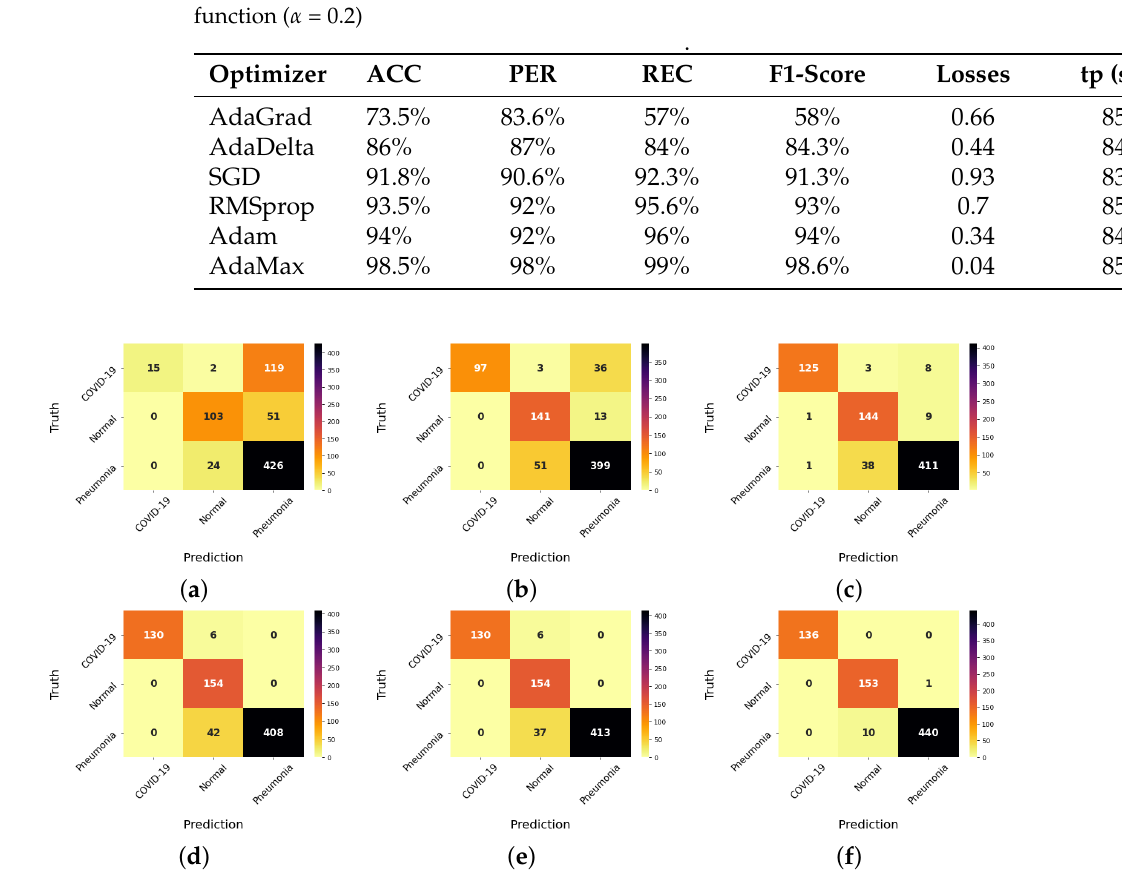
Figure 7. Confusion matrices of the proposed model using the ELU activation function ( α = 0.2) with different optimizers. ( a ) AdaGrad, ( b ) AdaDelta, ( c ) SGD, ( d ) RMSprop, ( e ) Adam, and ( f )